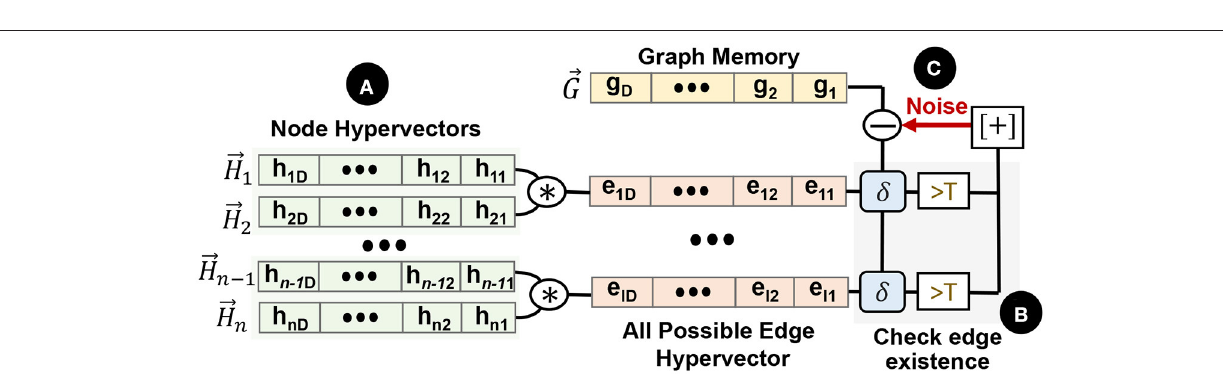
computed by checking the similarity of the edge hypervector with graph memory